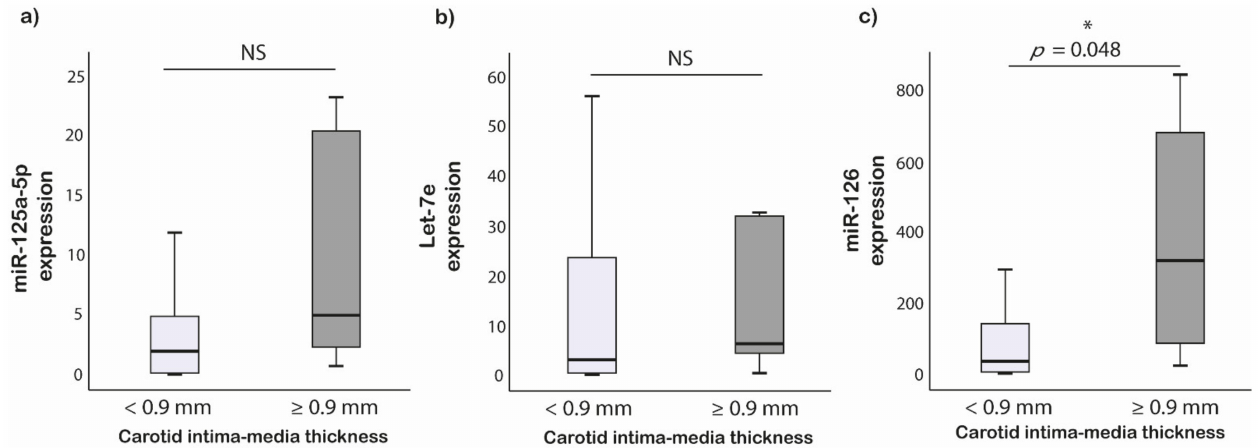
Figure 3. MiRNAs expression difference between CIMT groups in ultra-marathon runners. ( a ) miR-125a-5p; ( b ) Let-7e; ( c ) miR-126, * Comparison is significant at the 0.05